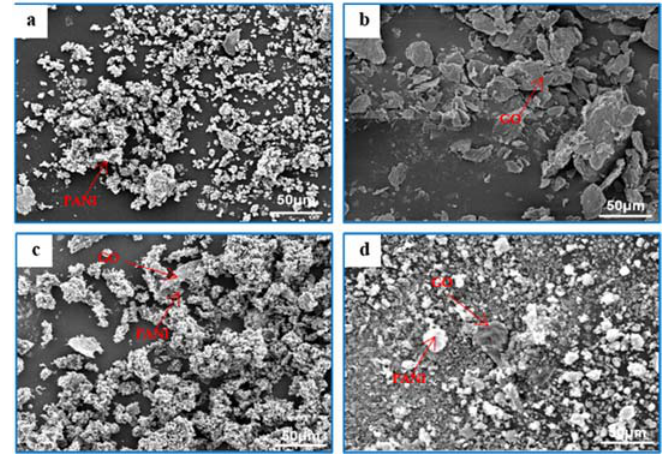
Figure 1. SEM of ( a ) PANI, ( b ) GO, ( c ) PAGO, and ( d ) PMGO powders.